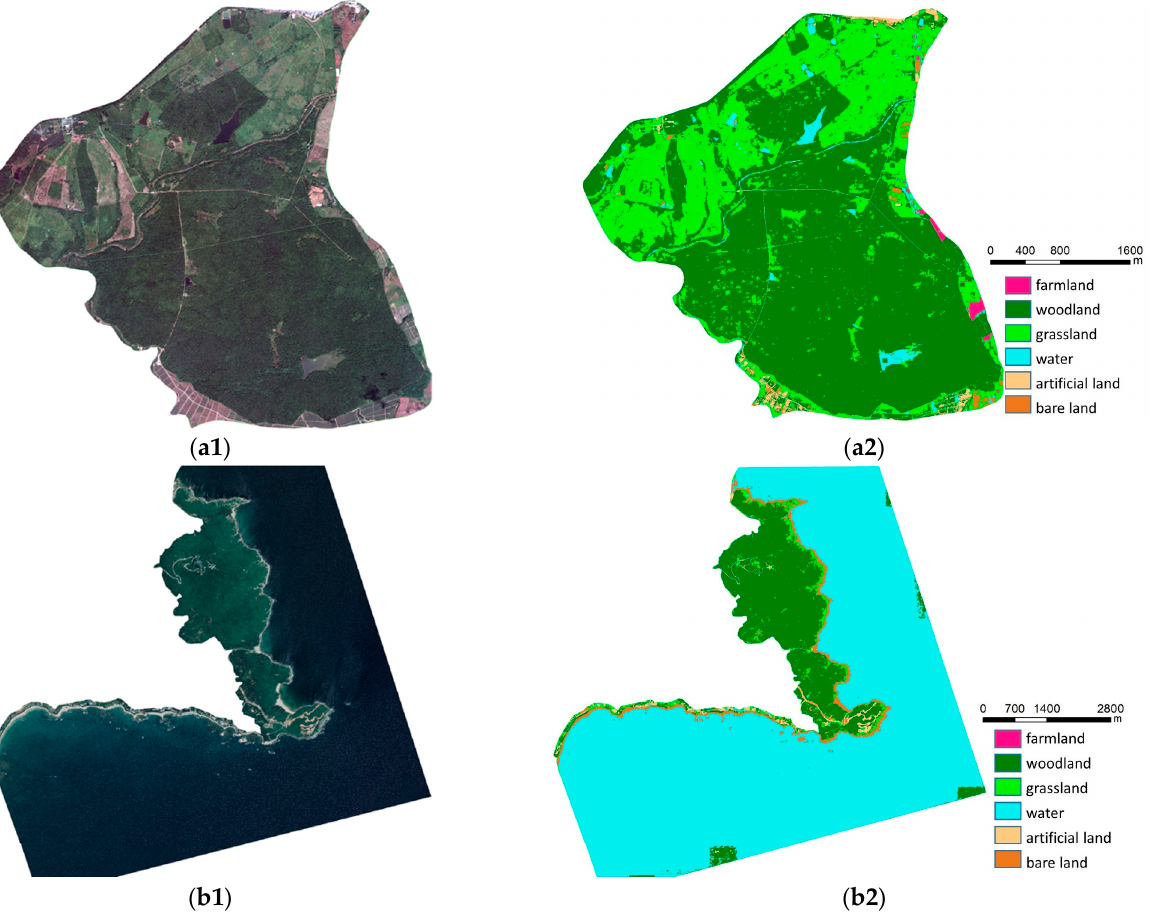
Figure 11. Classification results for nature reserves based on true color images. ( a1 ) Image of Datian Nature Reserve. ( a2 ) Label of Datian Nature Reserve. ( b1 ) Image of Tongguling Nature Reserve. ( b2 ) Label of Tongguling Nature Reserve.